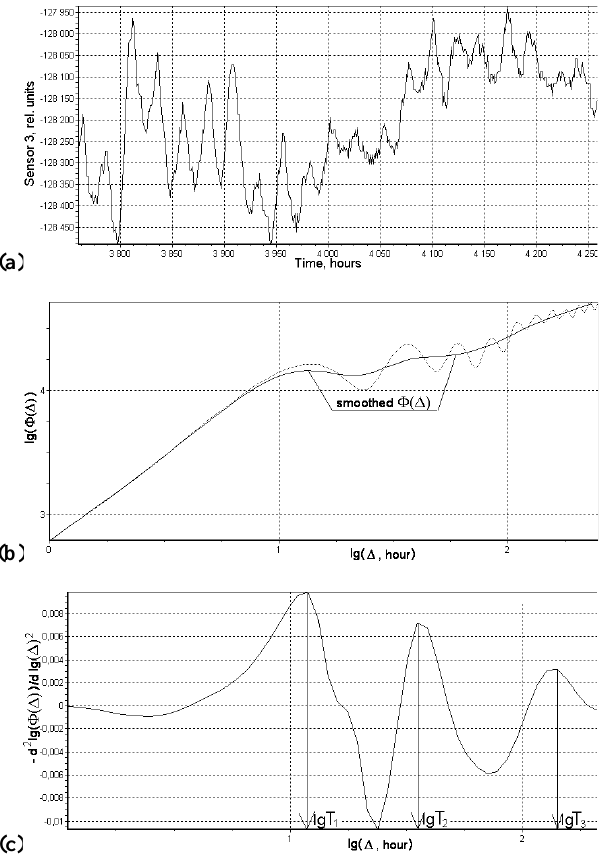
Fig. 2. SFCAM explanation. Window of sensor 3 signal (a) , its double logarithmic SF and smoothed double logarithmic SF (b) and negative second derivative (“curvature”) of smoothed double loga- rithmic SF (c) with indication of extremuma positions which give CTs